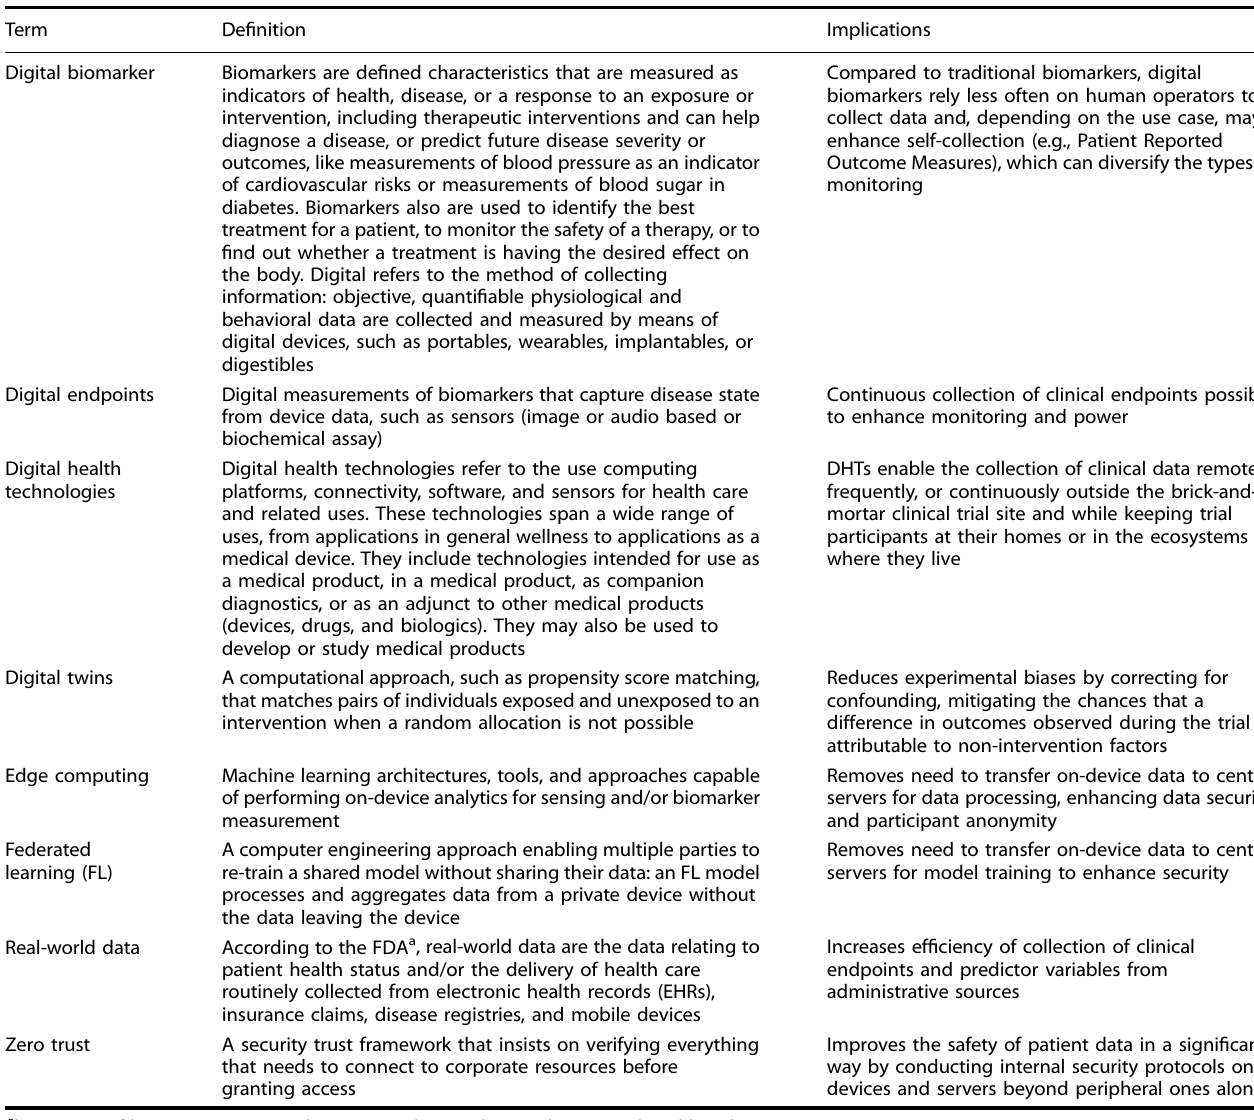
Table 1. Glossary of key technical